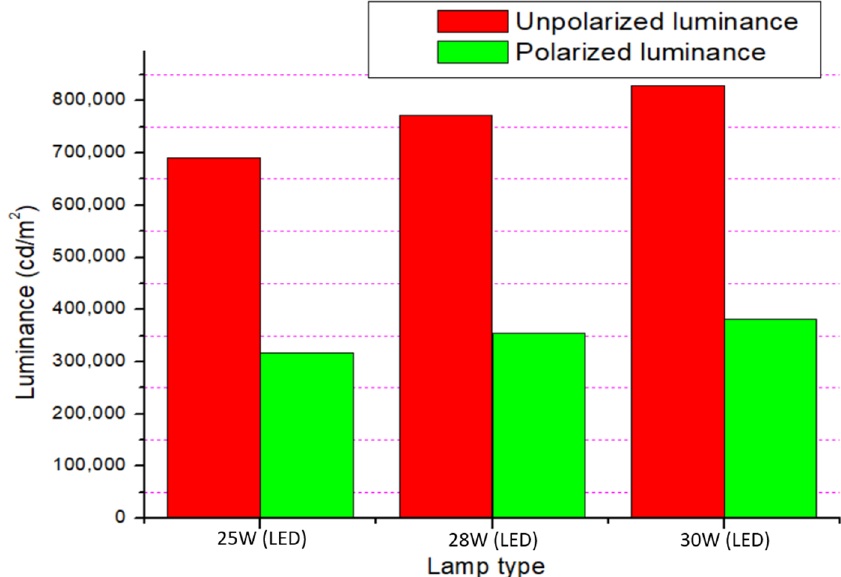
Figure 6. Luminance measurements of LED headlights with different powers (25 W, 28 W, and 30 W). Polarized luminance measurements were taken after light passed through only the headlights’ polarizing filter.